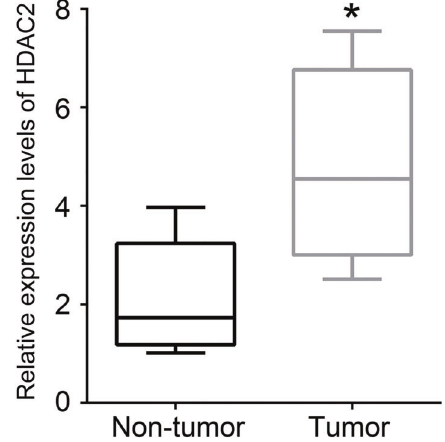
Figure 1. Expression of HDAC2 in human CRC tissues was higher than that in neighboring non-tumor colon tissues. Data are reported as the median of 20 independent experiments. Error bars indicate minimum and maximum. *P o 0.05 (two-tailed unpaired t -test). HDAC2: histone deacetylase 2; CRC: colorectal cancer.